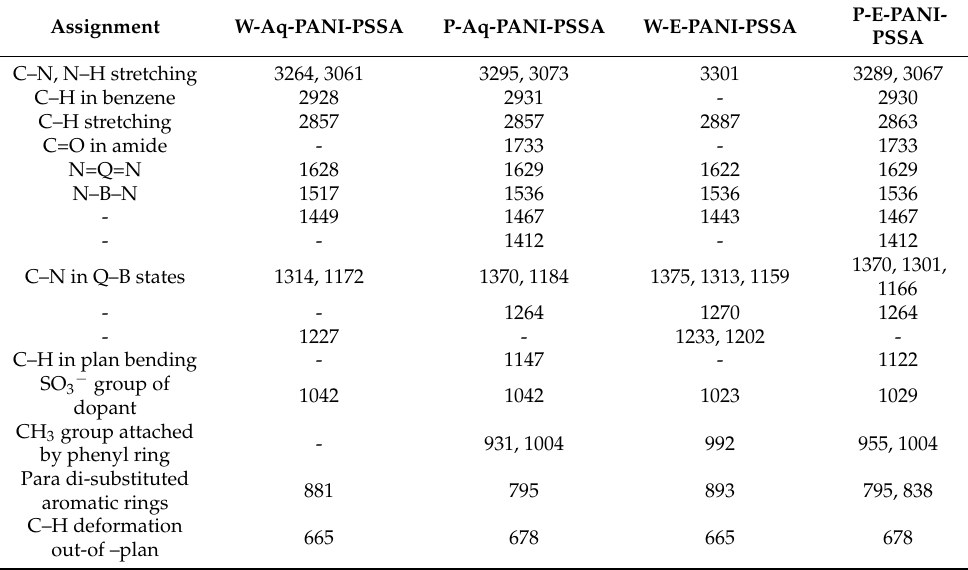
Figure 3. ATR spectra of PANI-PSSA coated textiles: ( a ) polyamide and ( b ) wool. Table 1. The frequencies characteristic to coated textiles and their